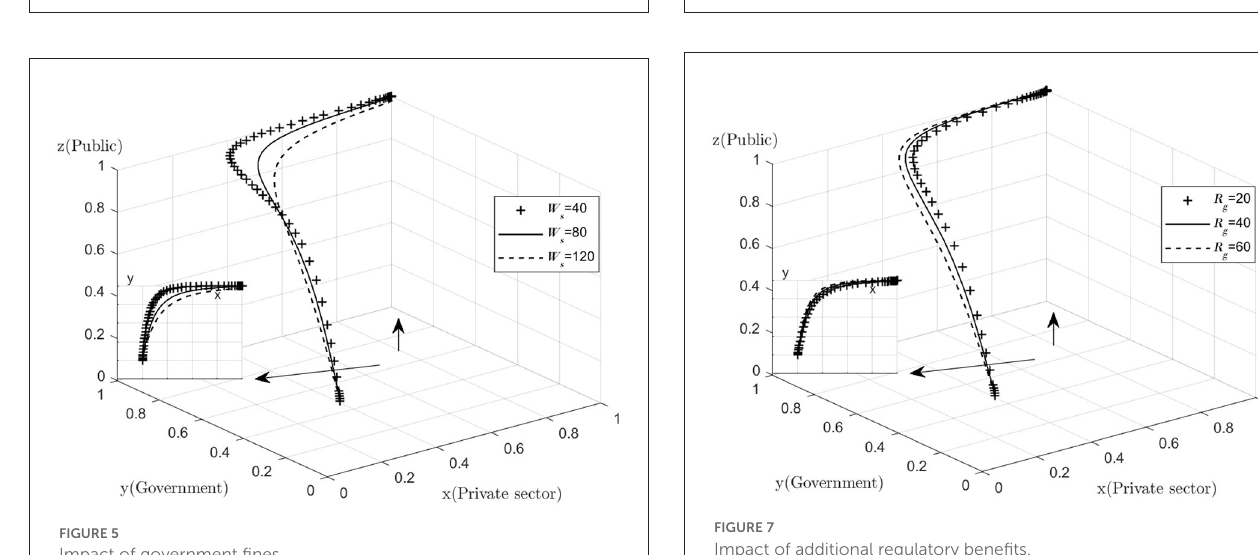
FIGURE4 Impact of operating subsidies.